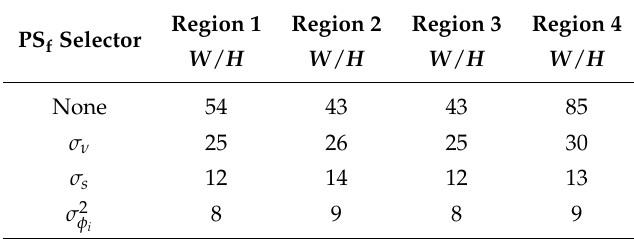
Table 3. Ratio W/H of the phase-offsets distributions of artificially disconnected